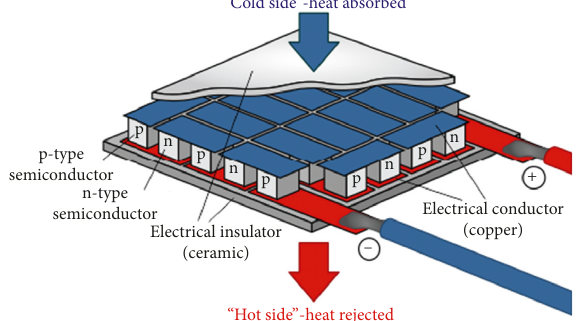
Figure 6: The construction and operation principle of the Peltier